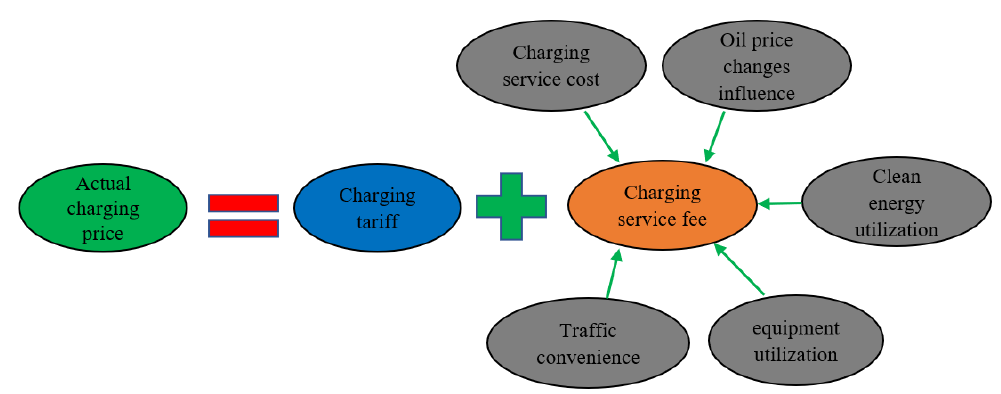
Figure 6. Charging service price mechanism and influencing factors.